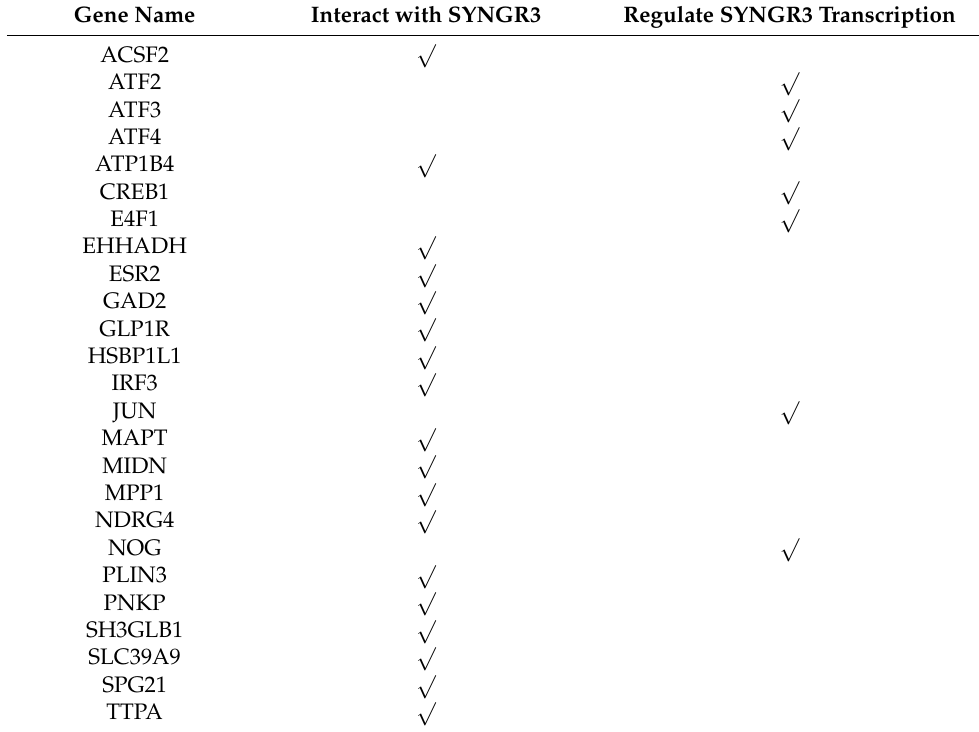
Table 1. List of genes showing the interaction and regulation of SYNGR3 (referenced from Path- ways Common (https://www.pathwaycommons.org/), a public pathway and interaction database, accessed on 1 March 2022) [7]. The seven transacting factors which exert control of SYNGR3 tran- scription are